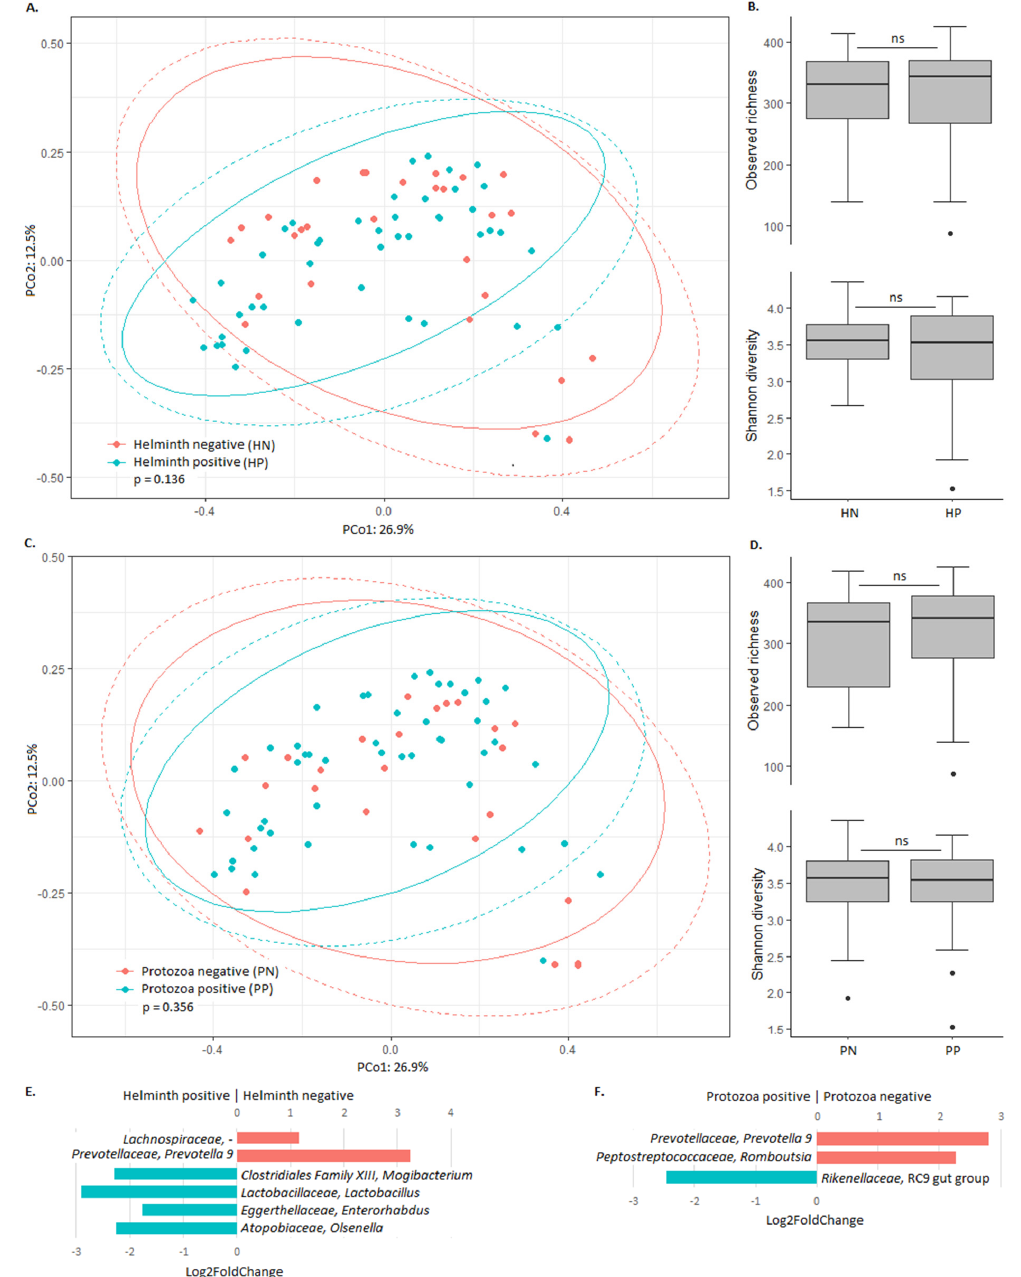
Figure 3. Association between the bacterial gut microbiota and helminth and protozoa infection in low SES children. ( A ) The Bray–Curtis dissimilarity-based principal coordinate analysis plot labelled according to helminth infection. Ellipses indicate confidence assuming a multivariate t-distribution (solid line) or a multivariate normal distribution (dotted line). ( B ) Alpha diversity in low SES children that are helminth negative (HN) and helminth positive (HP). Boxplots show the median, 25th and 75th percentiles, and minimal and maximal values with the exception of outliers (black circles). ( C ) The Bray–Curtis dissimilarity-based principal coordinate analysis plot labelled according to protozoa infection. Ellipses indicate confidence assuming a multivariate t-distribution (solid line) or a multivariate normal distribution (dotted line). ( D ) Alpha diversity in low SES children that are protozoa negative (PN) and protozoa positive (PP). Boxplots show the median, 25th and 75th percentiles, and minimal and maximal values with the exception of outliers (black circles). ( E ) Differential abundance of bacterial taxa between helminth positive and helminth negative low SES children. Taxa with Benjamini–Hochberg corrected p -value below 0.05 are shown. ( F ) Differential abundance of bacterial taxa between protozoa positive and protozoa negative low SES children. Taxa with Benjamini–Hochberg corrected p -value below 0.05 are